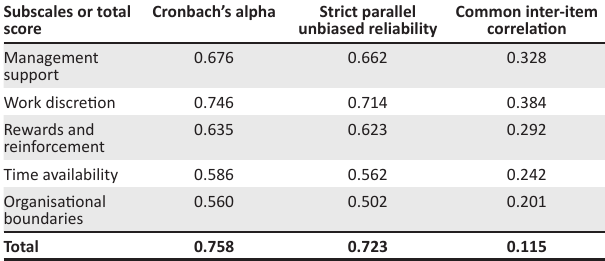
TABLE 3: Reliability coefficients and common inter-item correlation for subscales and Corporate Entrepreneurship Assessment Instrument total score.